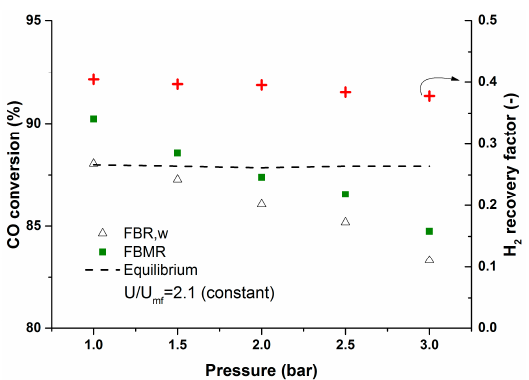
CO (10%), H 2 O (15%), N 2 balance, P permeate : 30